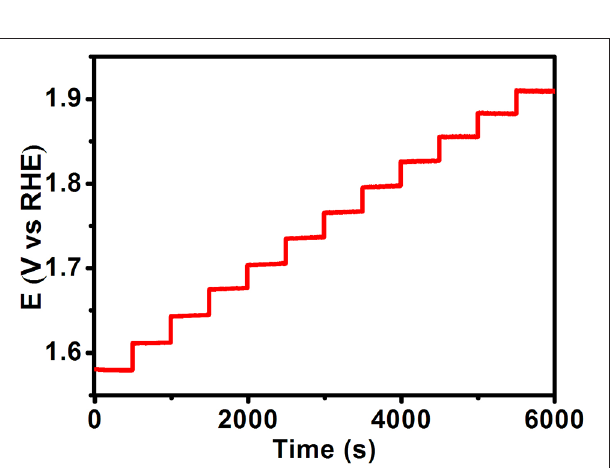
FIGURE 6 | Multistep chronopotentiometric of oxygen evolution reaction (OER) catalyst. The current density started at 60mA cm − 2 and finished at 280mA cm − 2 , with an increment of 20mA cm − 2 per 500s without ohmic potential drop (IR)